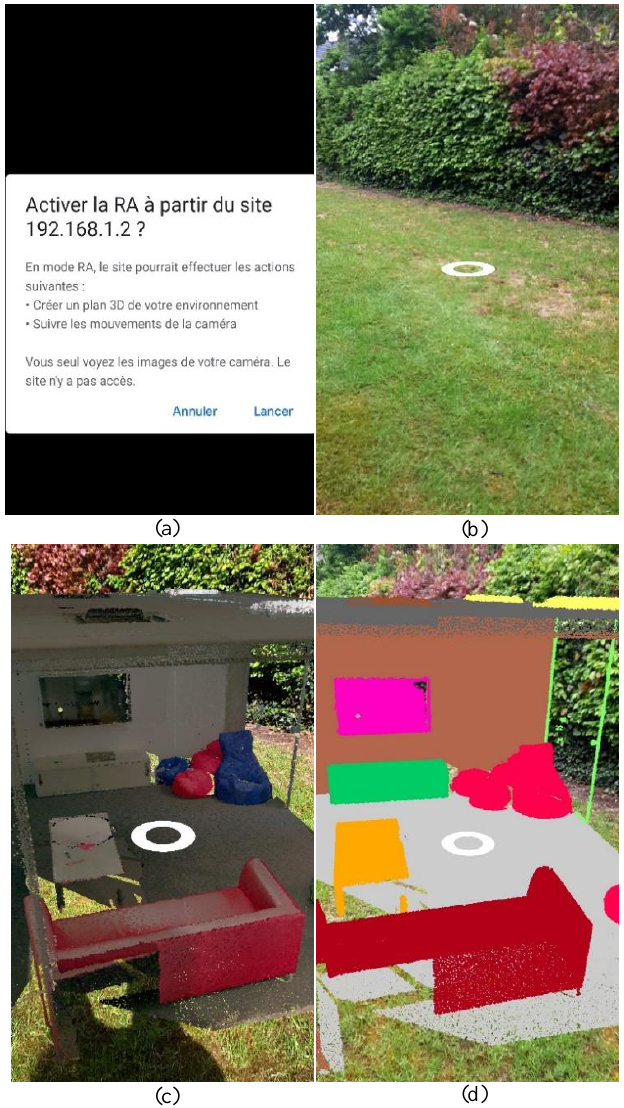
Figure 7. Result of a test with a point cloud; (a) creation of augmented reality session, (b) Hit-test to choose the anchor point, (c) point cloud in real color, (d) display in classes